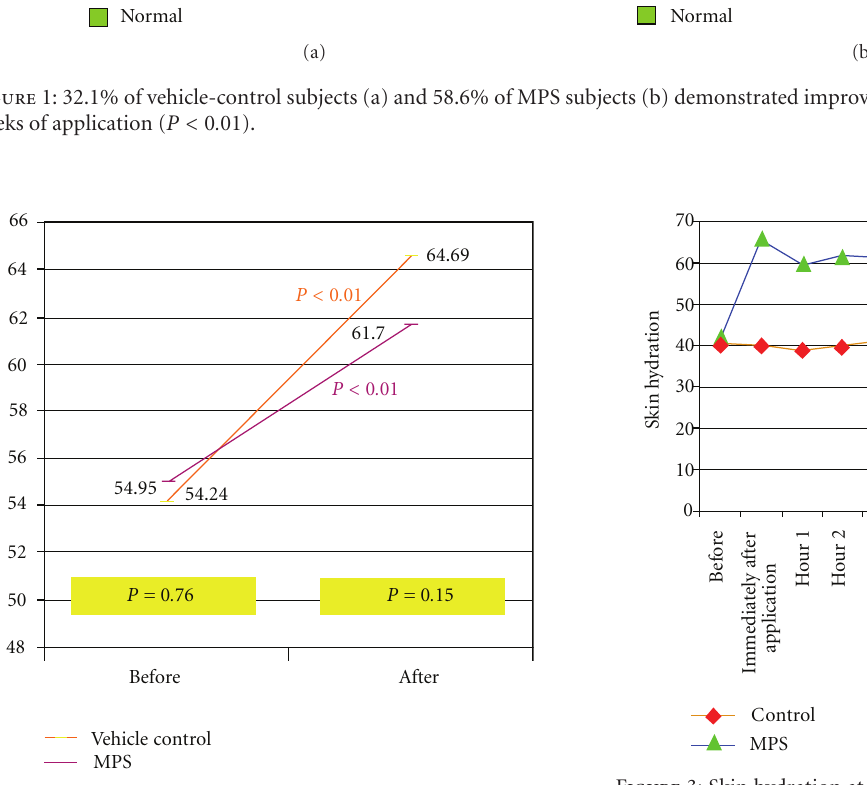
Figure 2: No significant di ff erence in skin elasticity between both groups ( P = 0 . 15).